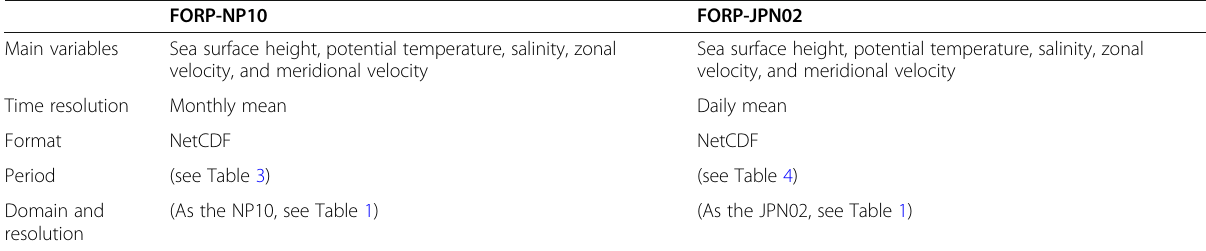
Table 5 Outline of the basic specifications of the FORP datasets (FORP-NP10 and FORP-JPN02)